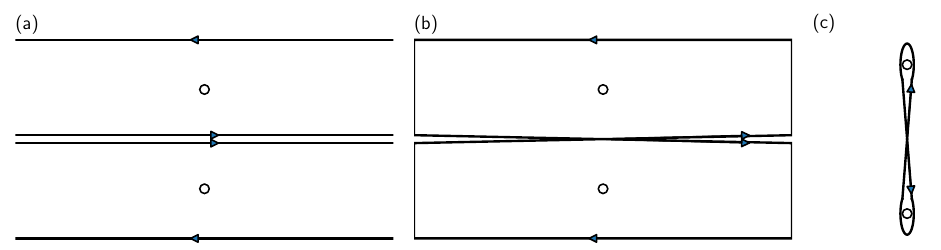
Figure 9 . The deformation of contour in (A.4). Panel (a) represents the original contour in (A.4). In Panel (b), we connect the infinities of (a) in a way compatible with the branch choices (the empty circles represents the two relevant branch cut singularities). We obtain a figure “8”, which is further deformed into Panel (c), which can be written as the difference between two integrals on the interval connecting the